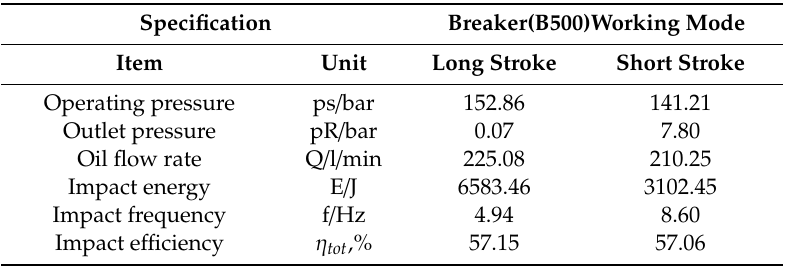
Table 5. Results of the impact e ffi